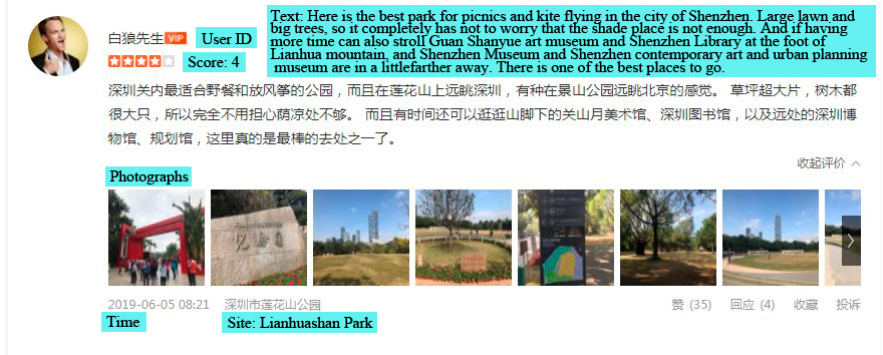
Figure 2. A screesnshot of online comments from the Dianping website (From http://www.dianping.com/shop/H6Z7zyY6lwRs0nTN/review_all). The English translation of Chinese characters in the figure is presented in the blue box.